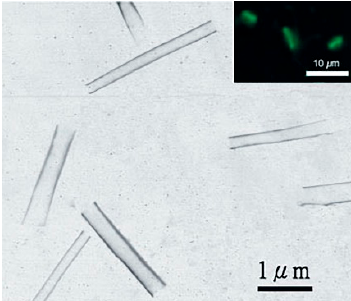
Figure 3. Transmission Electron Microscopy (TEM) and fluorescent images of fluorescent SNTs. Reproduced from [22], with permission from John Wiley and Sons.